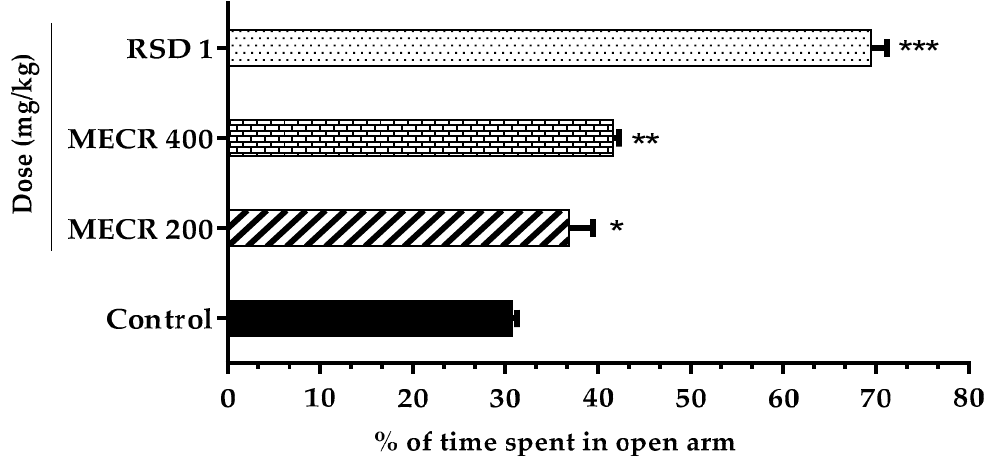
Figure 1. The effect of methanol extract of Cuscuta reflexa (MECR) in EPM test in mice. Values are expressed in mean ± SEM (n = 6). *p < 0.05, **p < 0.01 and ***p < 0.001 compared with the control group (Dunnett’s test). RSD: reference standard drug (Diazepam, 1 mg/kg).